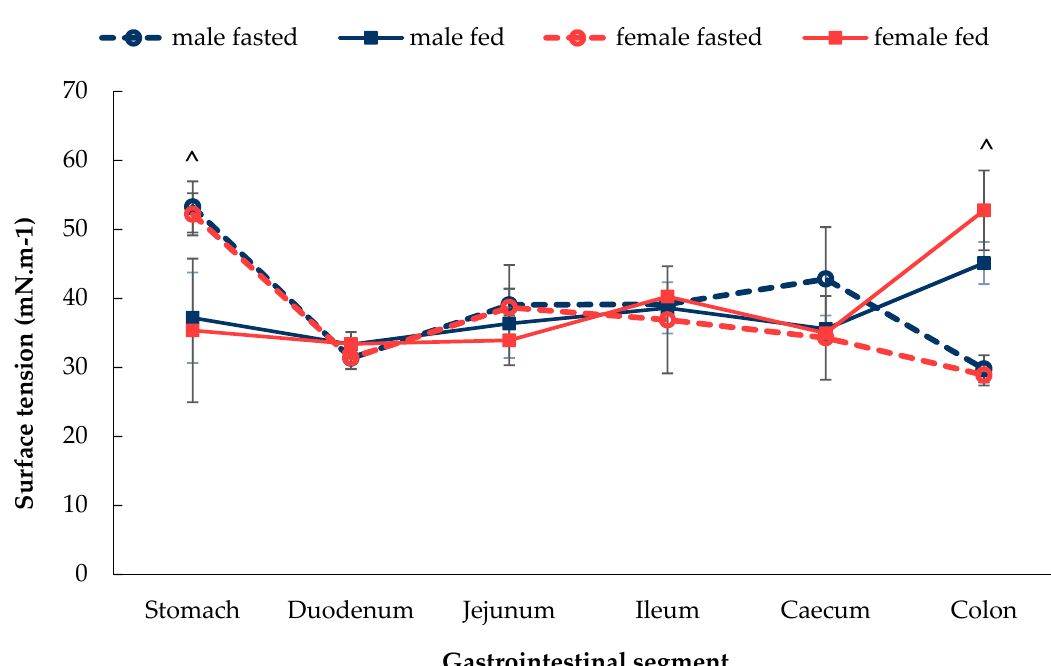
Figure 4. Surface tension of the fluids of sections of the GI tract of male and female in fasted state and fed state rats. (Mean ± SD, n = 6). The following symbol ^ denotes a statistical significance ( p < 0.05) between fasted and fed state in both male and female rats.